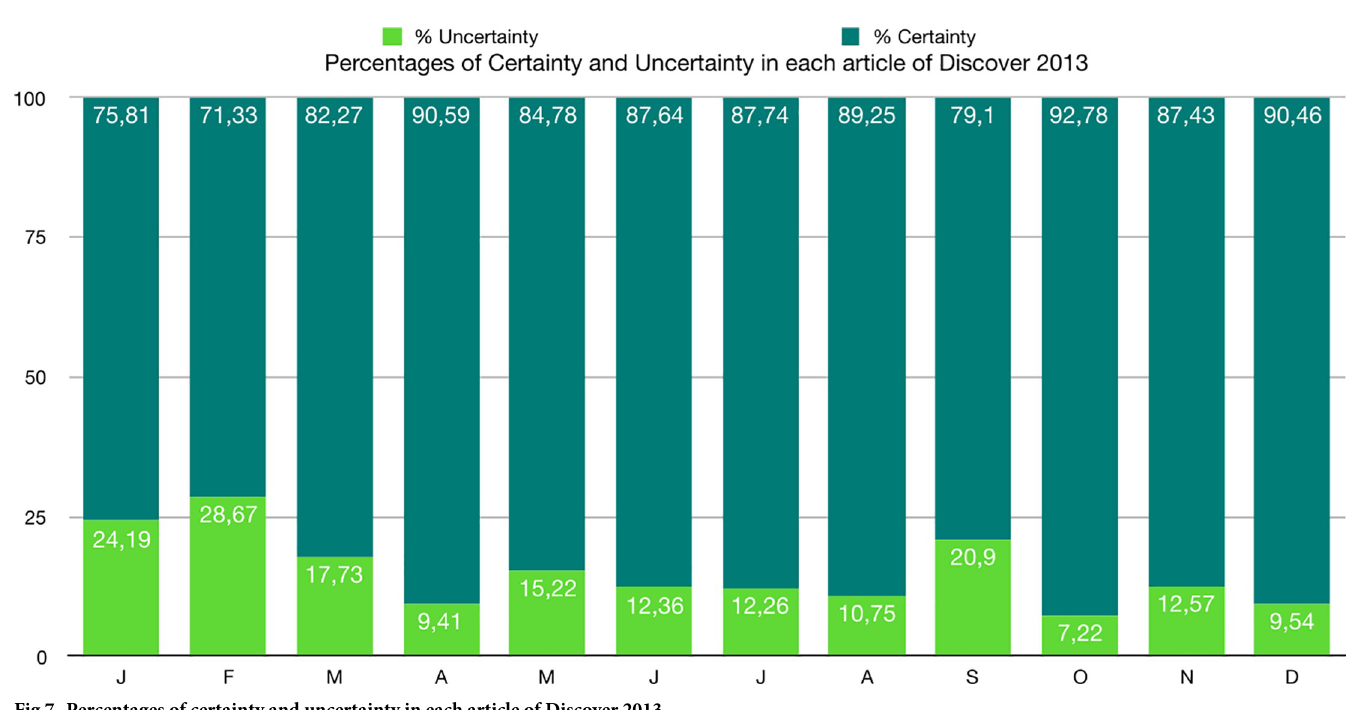
PLOS ONE | https://doi.org/10.1371/journal.pone.0221933 September 5,